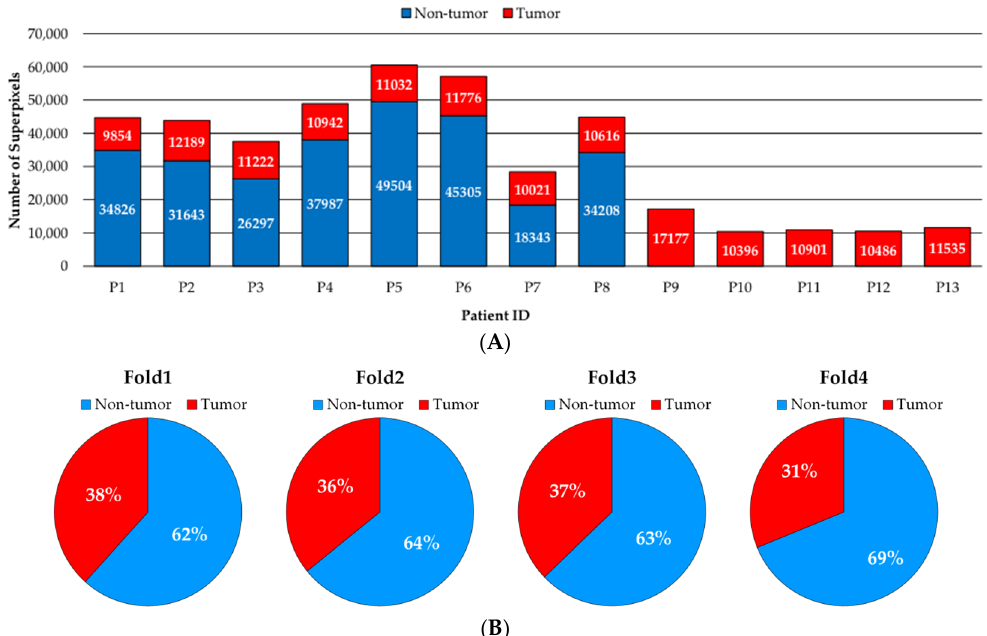
Figure 9. Number of non-tumor and tumor superpixels per patient ( A ) and percentage of the total per fold ( B ).